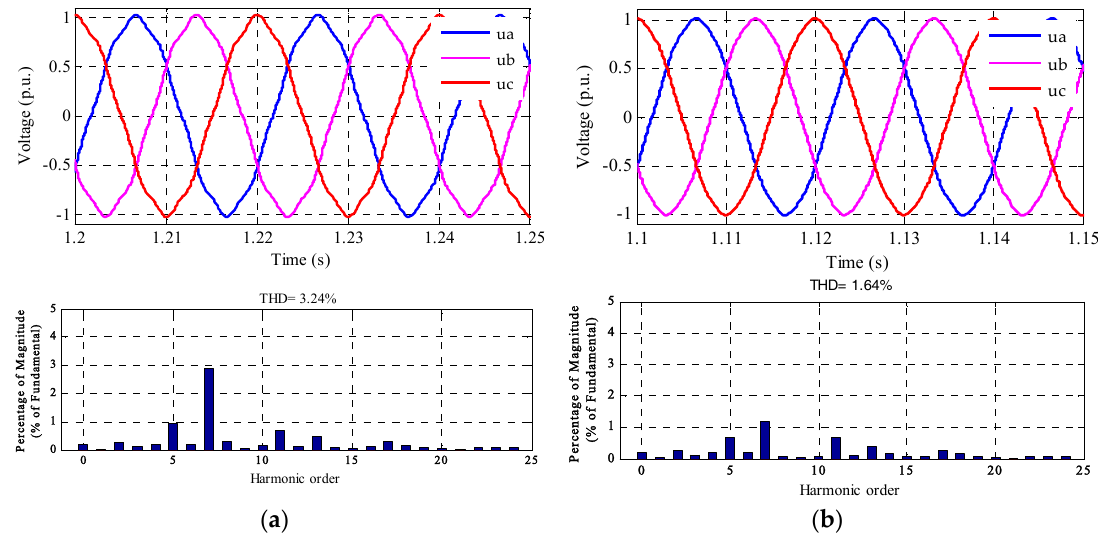
Figure 12. ( a ) 3-phase voltage waveform and spectrum of grid access point when the 20 km is connected; ( b ) 3-phase voltage waveform and spectrum of 7th harmonic after being damped by the selective harmonic damping (SHD) method.